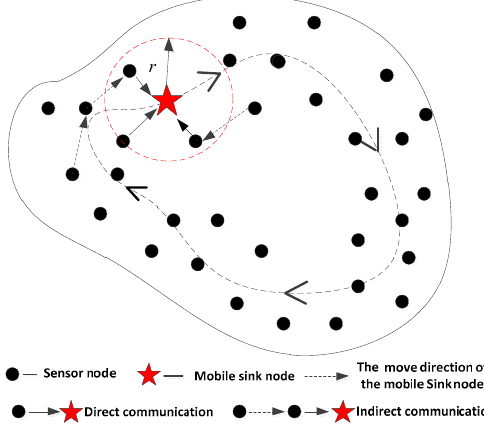
Figure 1. A schematic diagram of a wireless sensor network with a mobile sink.